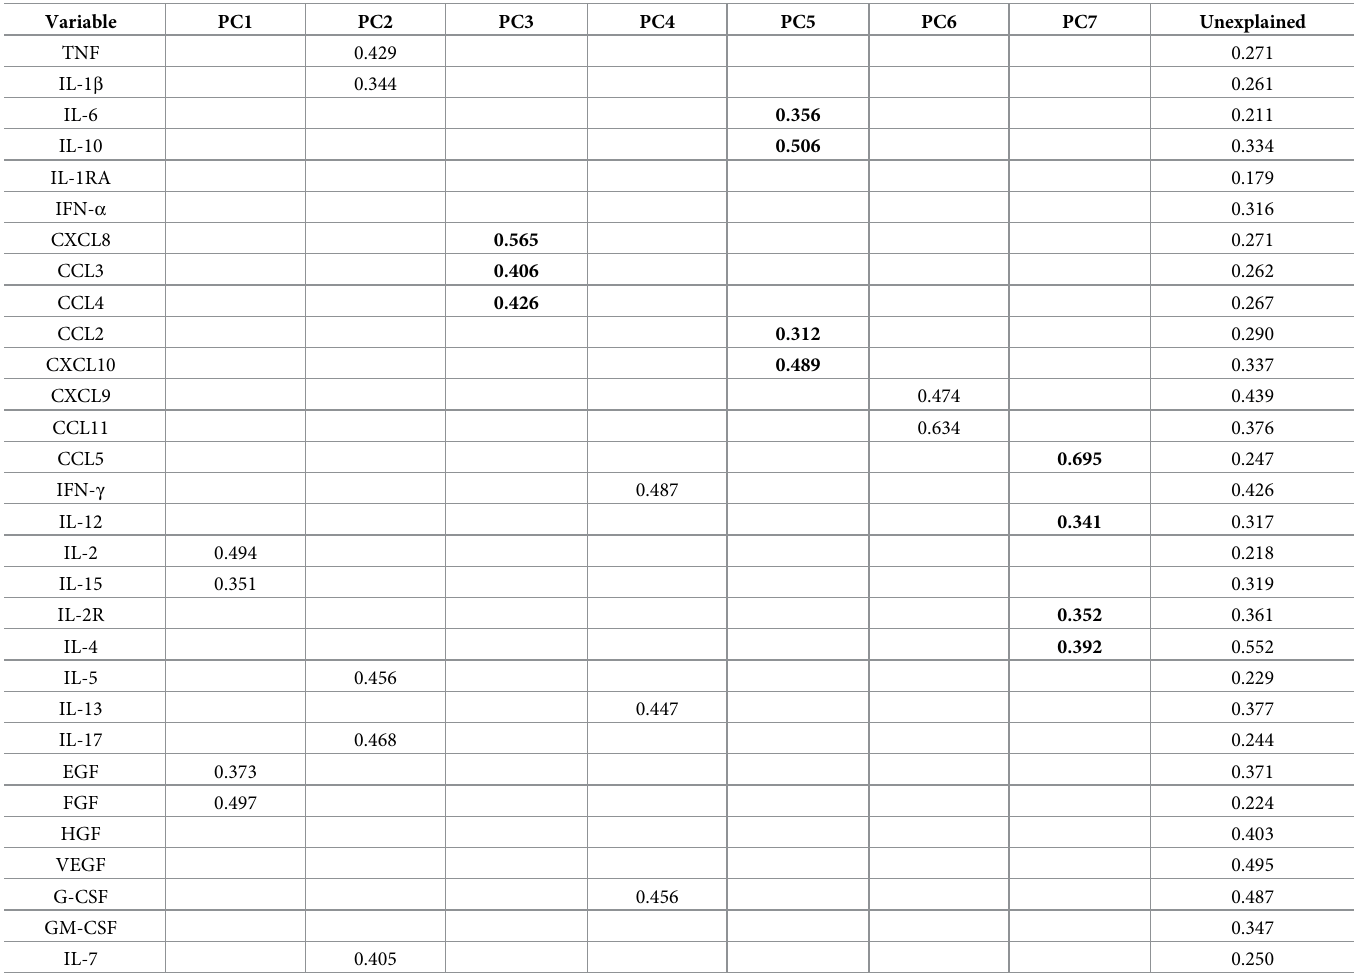
Loading scores for each principal component (PC) with Eigenvalue > 1 and proportion of unexplained variance after varimax rotation. In bold the PC with a positive association with P . vivax infection. Only shown if loading score >